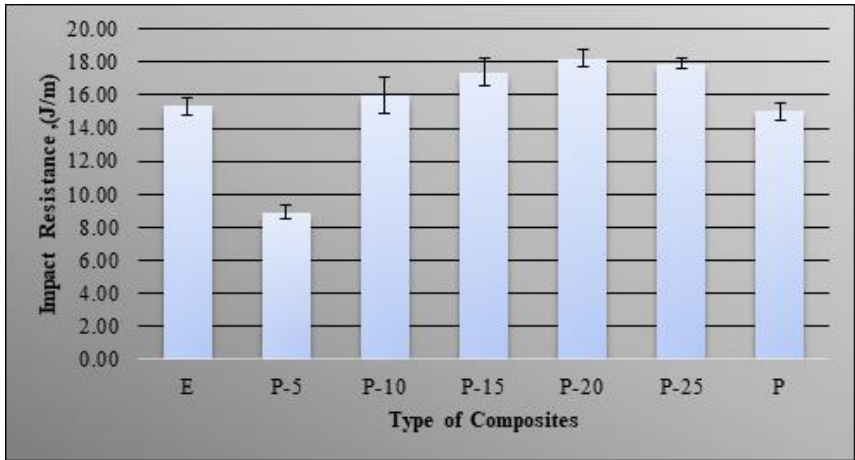
Figure 7. Impact resistance of bio-phenolic/epoxy blends, neat epoxy and bio-phenolic.